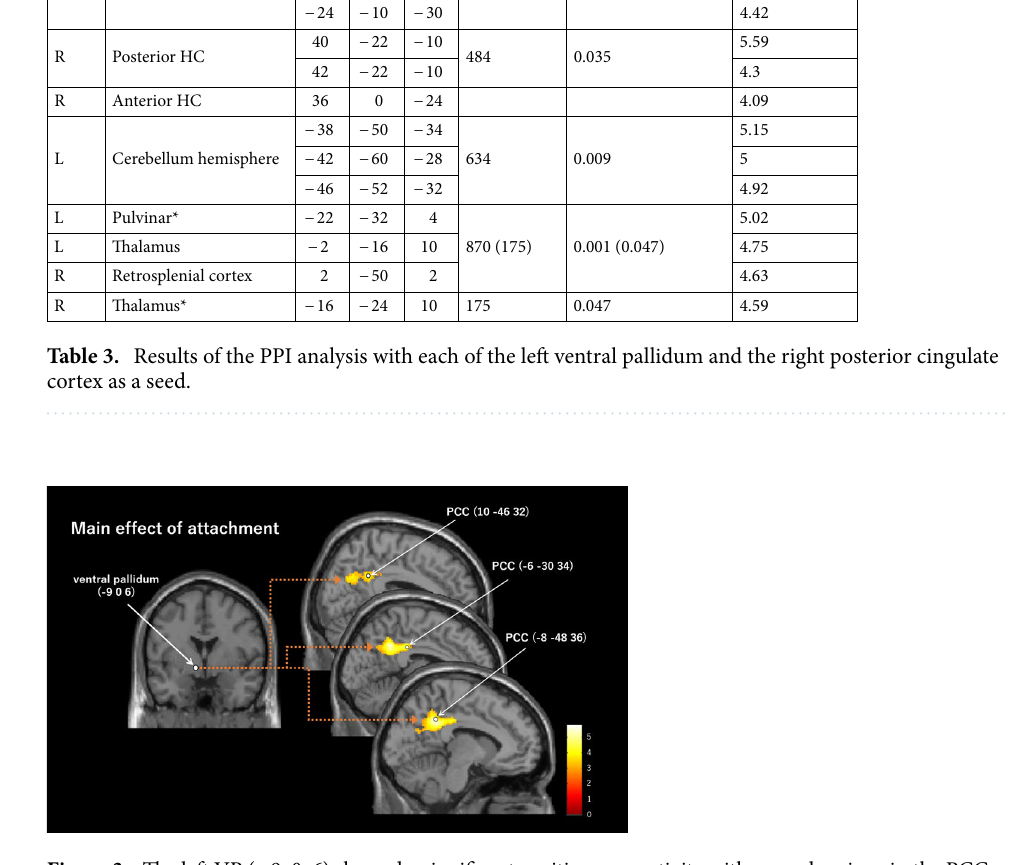
Figure 3. The left VP (− 9, 0, 6) showed a significant positive connectivity with several regions in the PCC ([− 8, − 48, 36], [− 6, − 30, 34], and [10, − 46, 32]) in the main effect of attachment. PCC, posterior cingulate cortex; VP, ventral